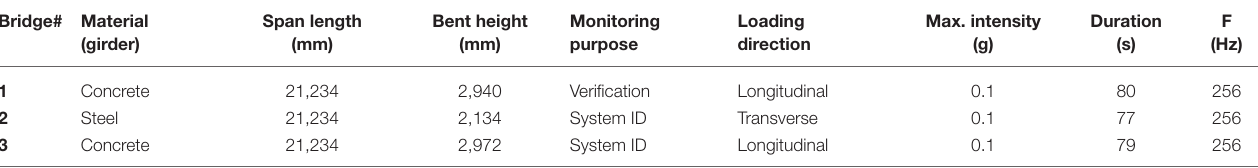
TABLE 1 | Bridge dimensions and test setup. Bridge# Material (girder)